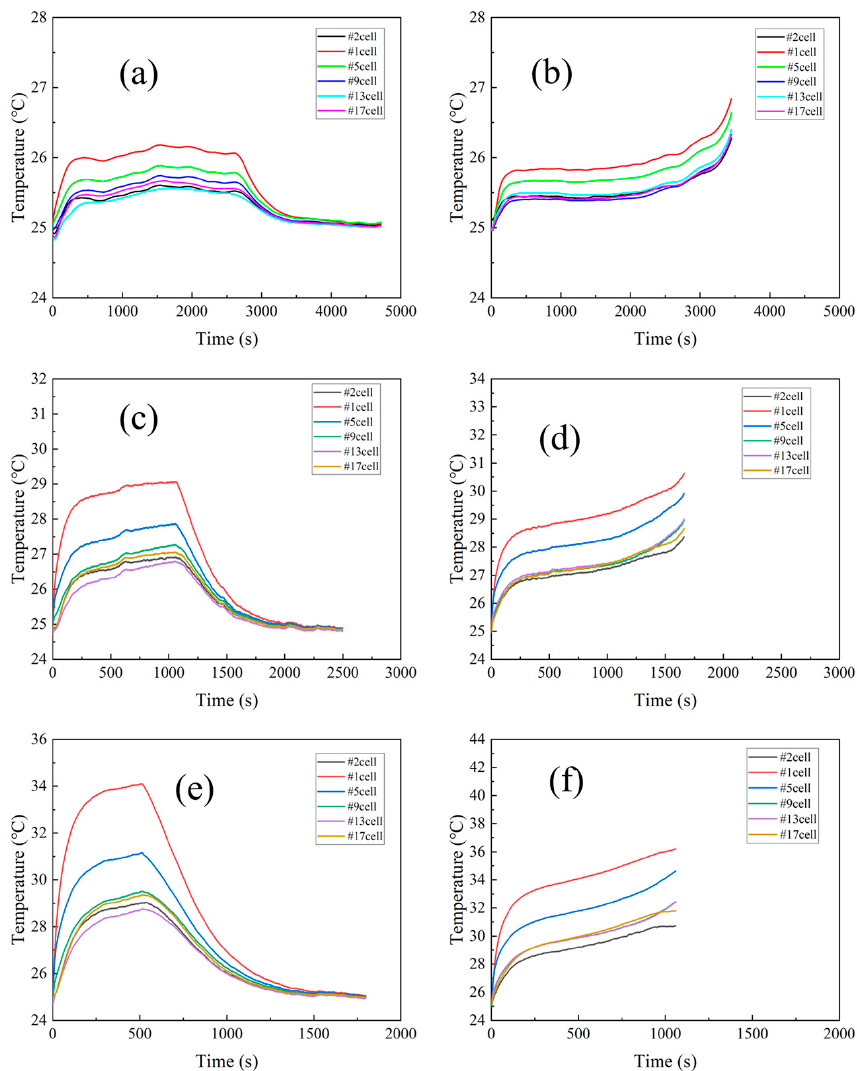
Figure 5. The change in ba tt ery module temperature with di ff erent discharge and charge rates. ( a ) 1C charge, ( b ) 1C discharge, ( c ) 2C charge, ( d ) 2C discharge, ( e ) 3C charge, and ( f ) 3C discharge.